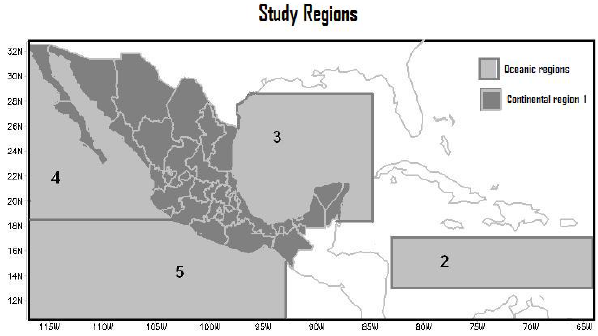
Fig. 2. Map delimiting the 5 different sub-regions considered: (1) continental Mexico, (2) Caribbean, (3) Gulf of Mexico, (4) Sub- Tropical Pacific and (5) Tropical